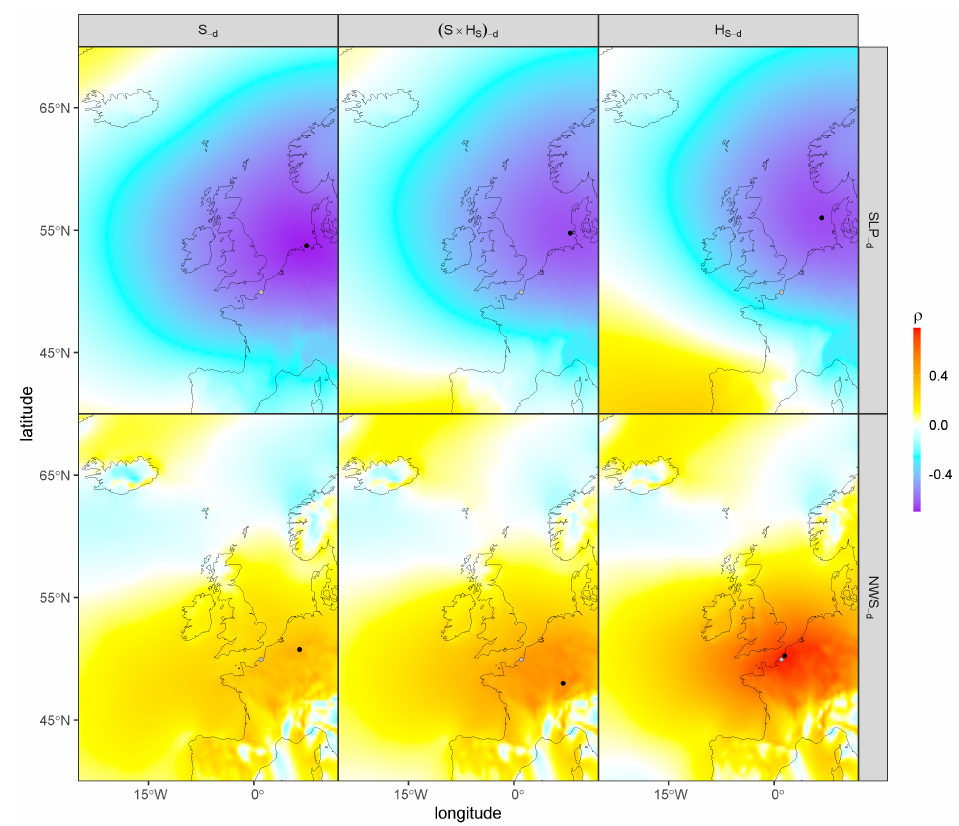
Figure 3. Correlation (Pearson’s ρ , color coded) between the variables’ residuals (with the season removed) S − d , H S − d and (S × H S ) − d (columns) and the covariate fields’ residuals SLP − d and NWS − d (rows). The grey dot indicates the locations of both Dieppe’s tide gauge and the H S time series, while the black dot indicates the point of maximal absolute correlation for each combination of variable and covariate